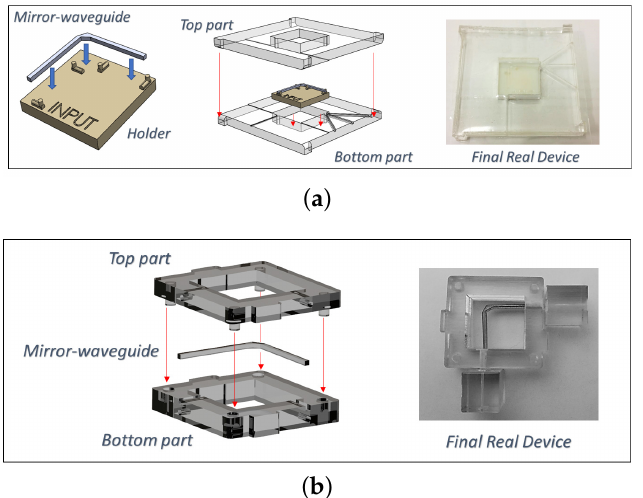
Figure 5. Steps in the realization of the two testing platforms used for the characterization of the ( a ) PDMS- µ SPT and ( b ) VeroClear- µ SPT . In both figures, on the left, the holder is designed to support the micro-optical component and the scheme of the holder with the top and bottom layers is used for the fiber alignment; on the right the photo of the complete micro-optical systems.